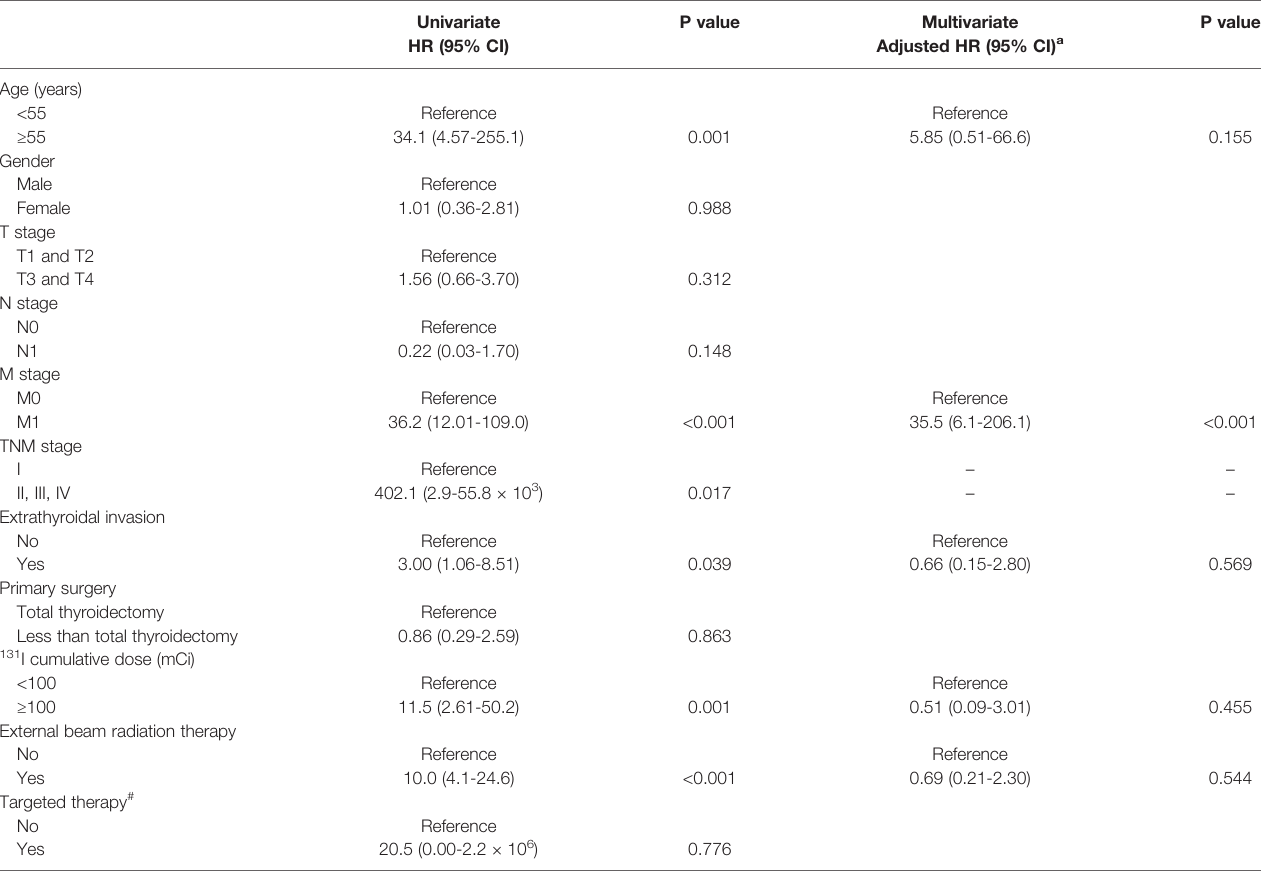
TABLE 3 | Risk factors associated with cancer-speci fi c mortality in 190 patients with follicular thyroid